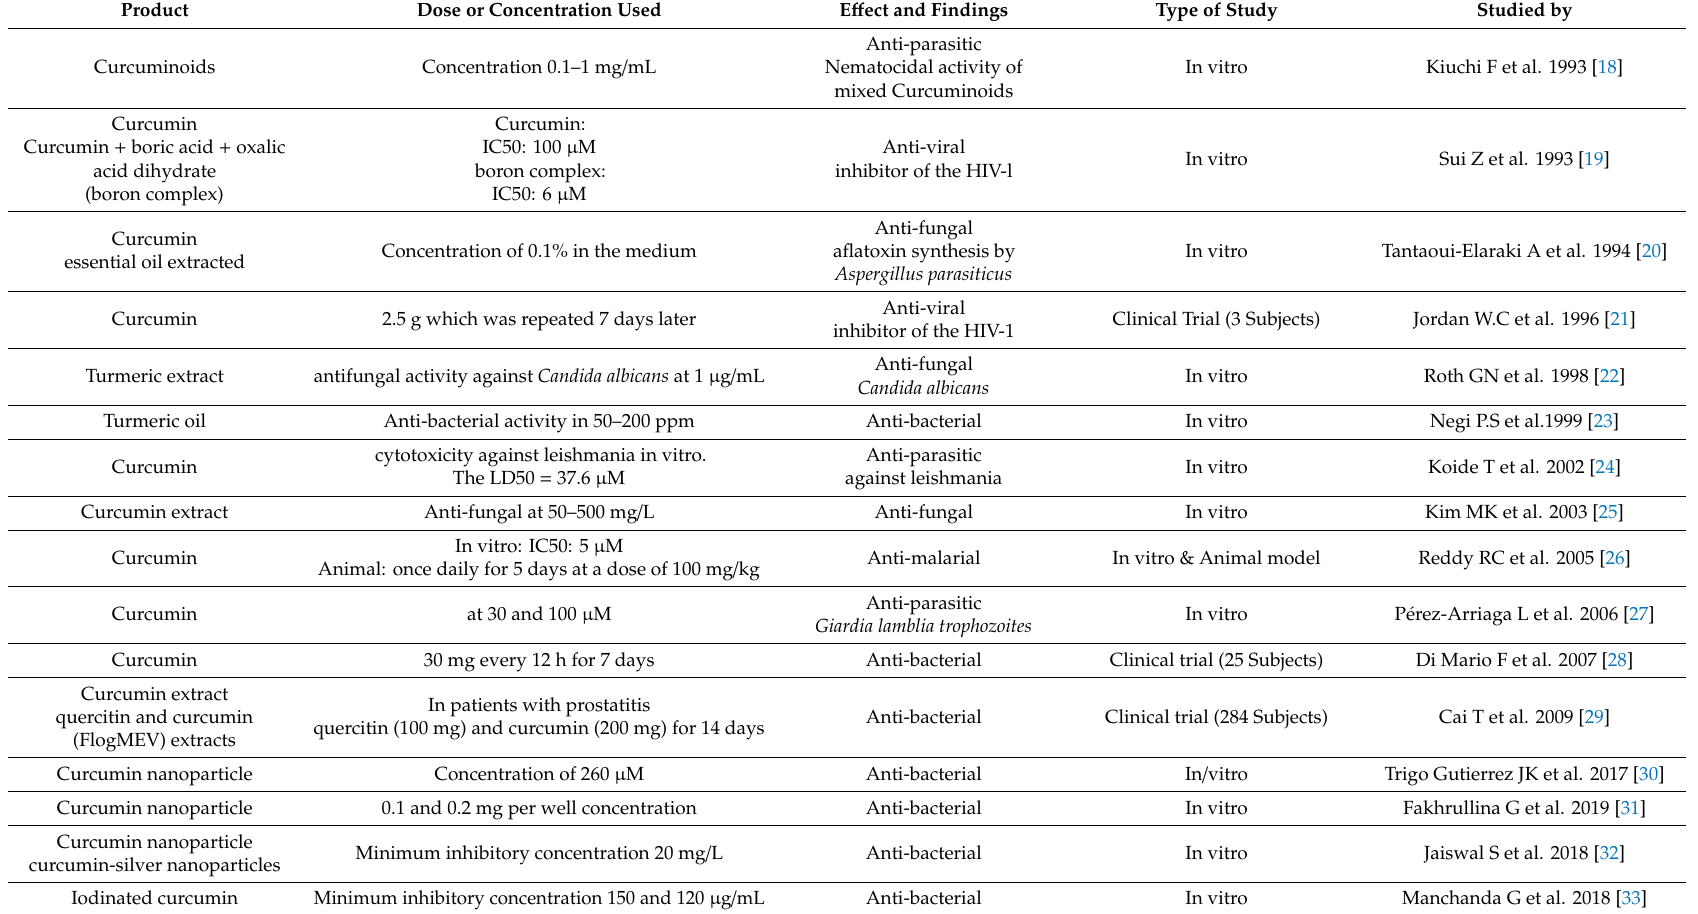
Table 1. Antimicrobial E ff ect of